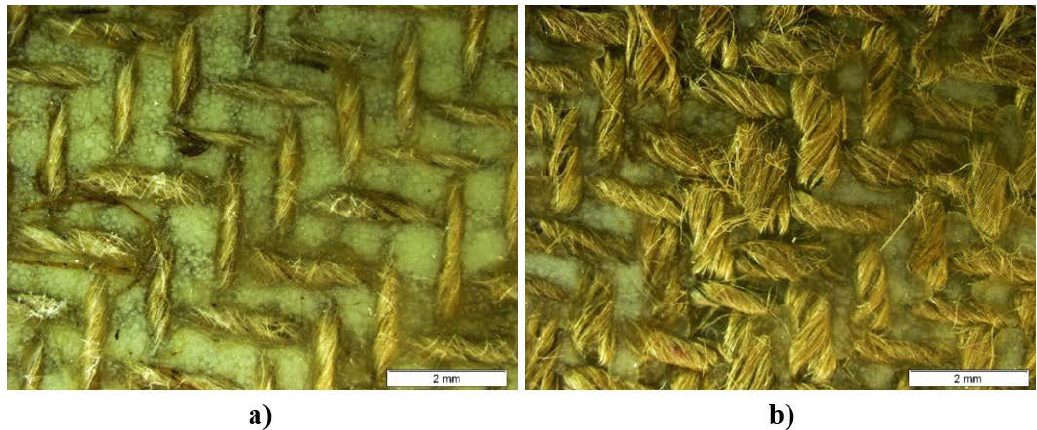
Figure 5: Polypropylene with linen fabric and 60% additive: (a) Without treatment (b) With alkali treatment.